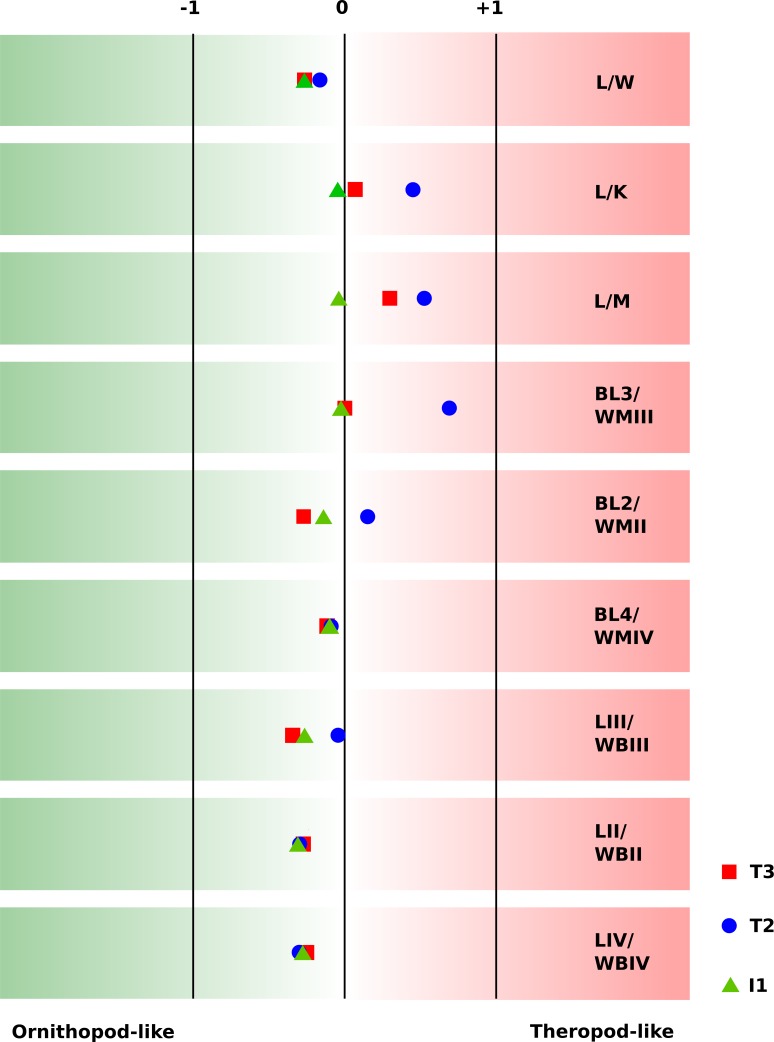
Multivariate analysis of the T3, T2 and I1 mean shapes, adopting the approach of Moratalla, Sanz and Jimenez (1988) for the discrimination between ornithopod and theropod footprints.Red squares represent the T3 trackway (large theropod), blue circles the T2 trackway (mid-sized theropod) and the green triangles the I1 trackway (ornithopod). A clear separation between the theropod and the ornithopod trackways is not possible in this case. The graphical depiction follows Romilio and Salisbury (2011) and Schulp and Al-Wosabi (2012). Measurements are indicated in Fig. 8.